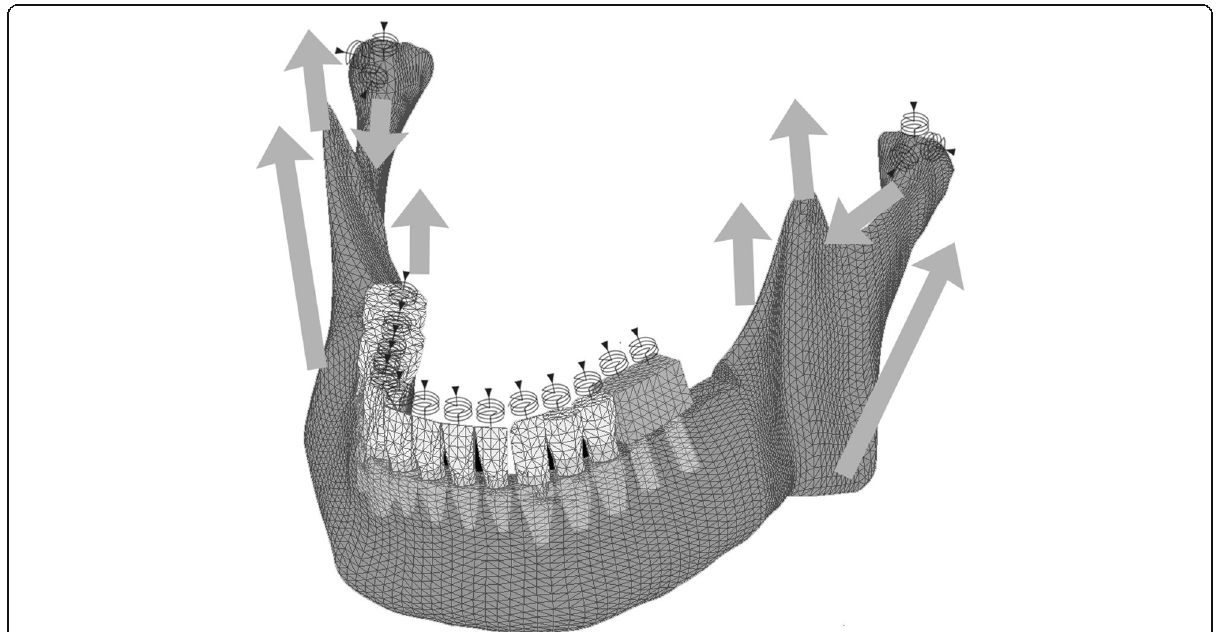
Fig. 6 Springs for opposing teeth and TMJs and load directions. Arrows indicate loads, arrowheads indicate restricted nods, and spiral lines indicate springs